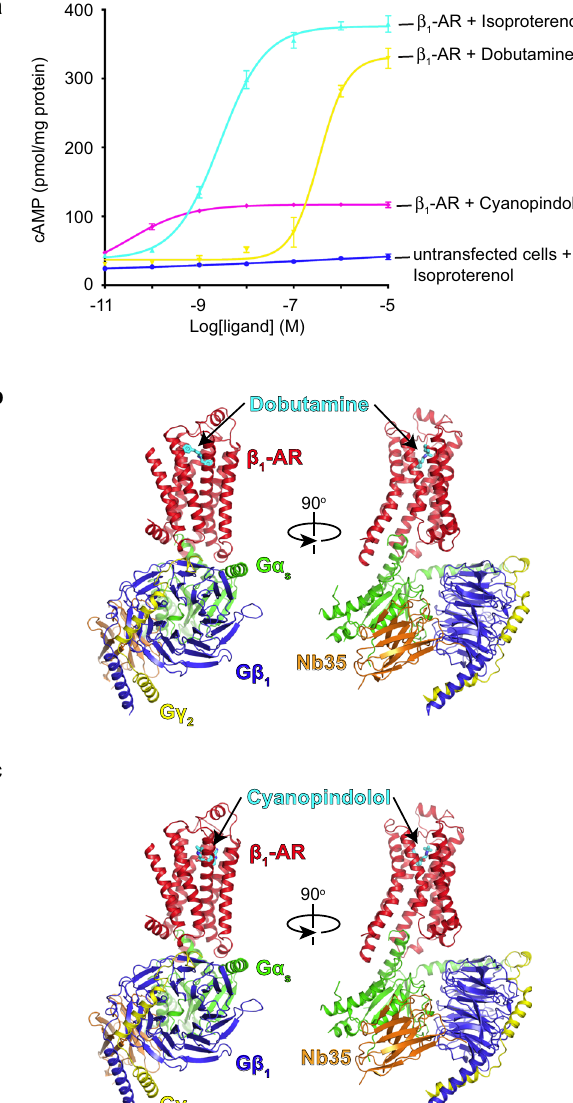
Fig. 1 Cryo-EM structures of the complexes of Gs and β 1 -AR bound with a partial agonist or a very weak partial agonist. a Comparison of the cellular cAMP responses induced by isoproterenol, dobutamine, and cyanopindolol. Data are presented as mean ± SD of three experiments. Source data are provided as a Source Data fi le. b Cartoon diagrams of the dobutamine – β 1 - AR – Gs complex are shown. c Cartoon diagrams of the cyanopindolol – β 1 - AR – Gs complex are shown. β 1 -AR in red, Ras-like GTPase domain of G α s in green, G β in blue, G γ in yellow, and Nb35 nanobody in ef fi cacy of cyanopindolol (Fig. 3f). These functional data supports the above structural studies identifying these residues involved in speci fi c interactions with the different ligands. β – Gs complexes . β 1 -AR conformations within the three 1 -AR